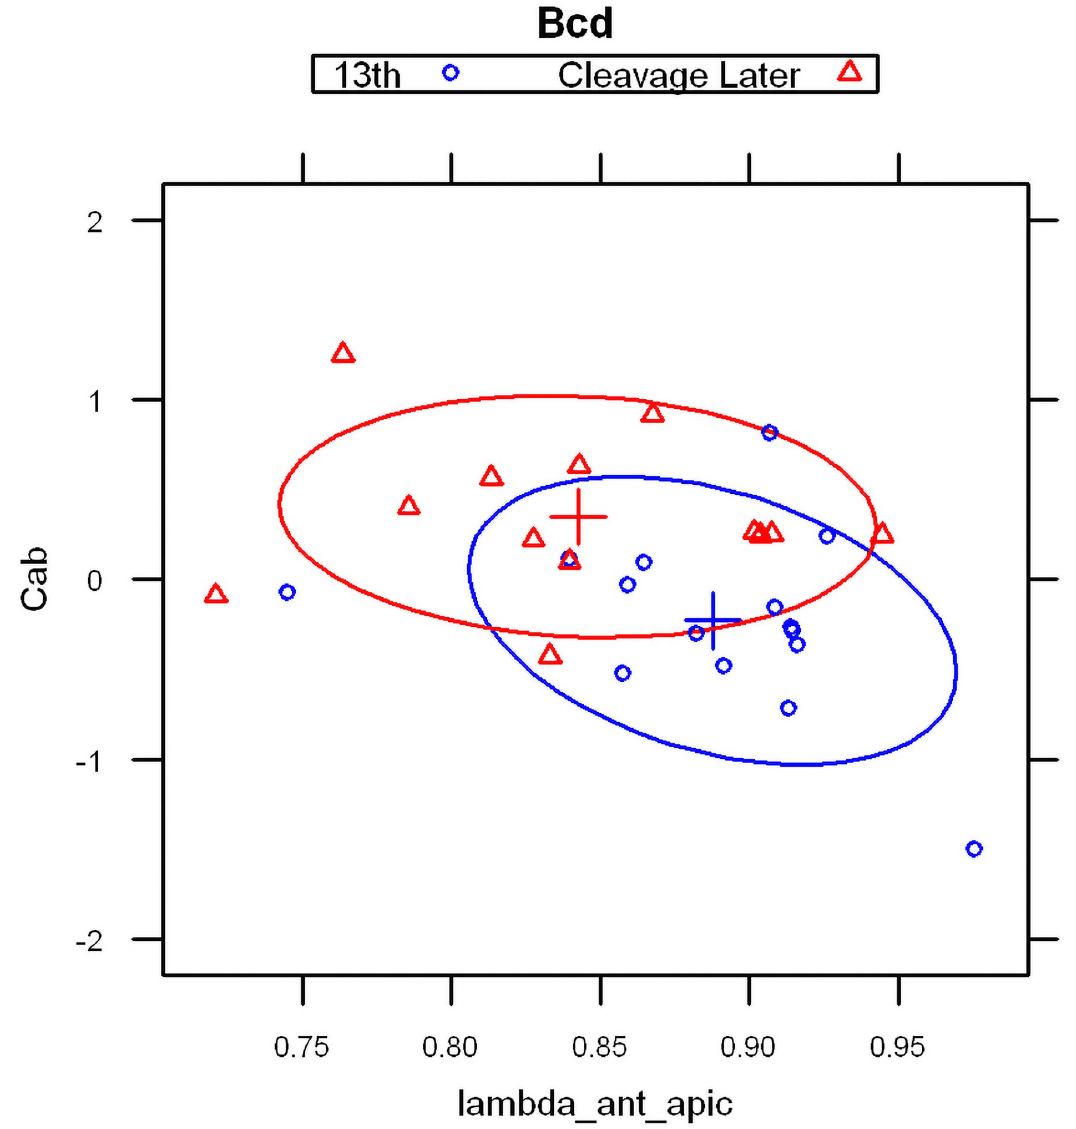
� � Þ ) for embryos from cleavage late and syncytial vs C ab ¼ In C apical ð Þ = C basal ð Þ anterior anterior anterior